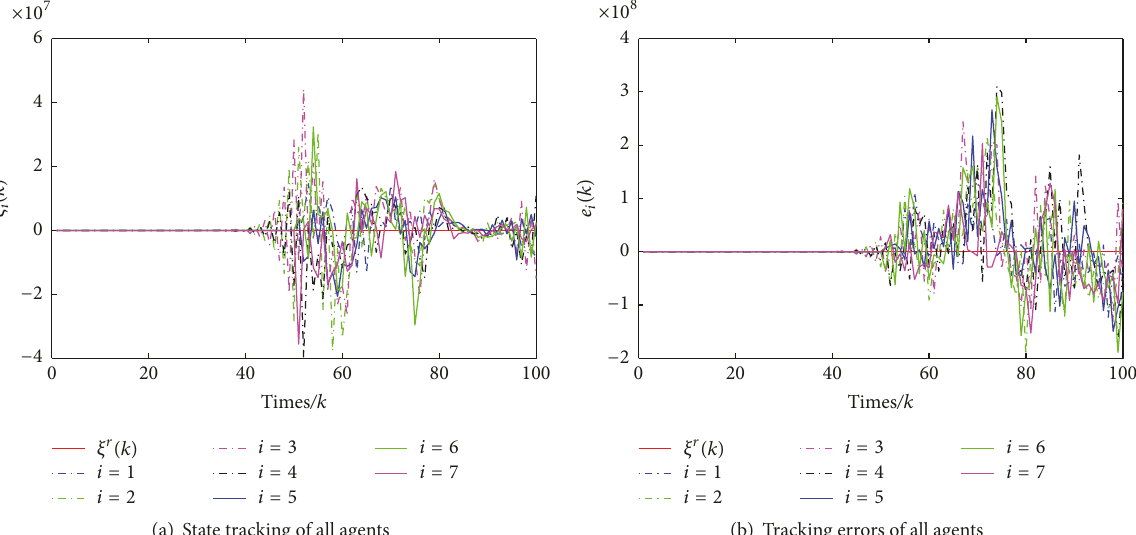
Figure 6: Simulation results in Case